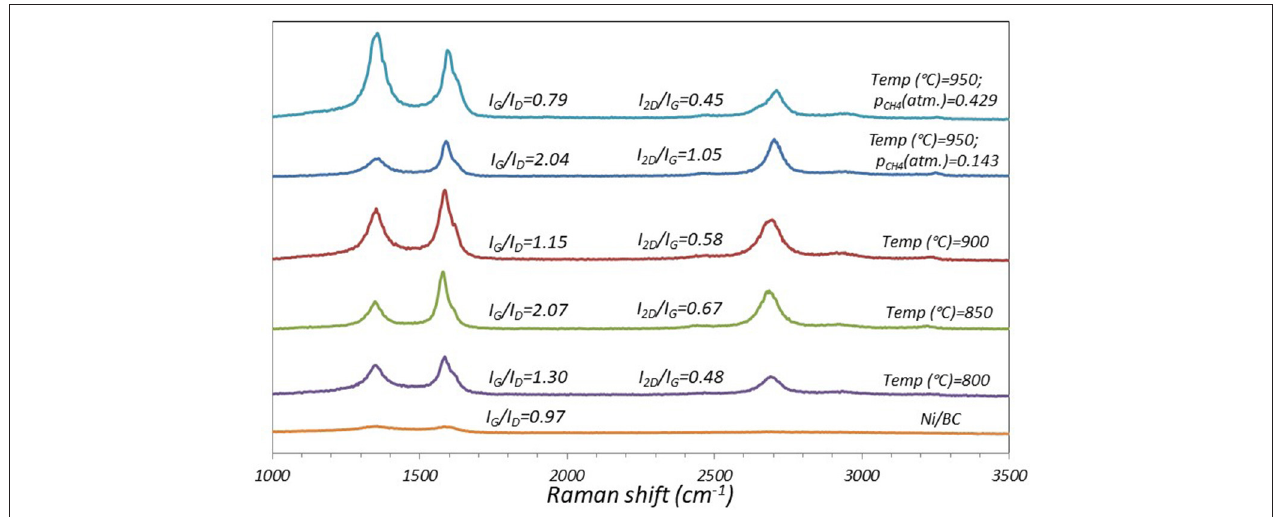
FIGURE 5 | Raman spectra of fresh catalyst and after reaction at different temperatures and with different methane concentrations.